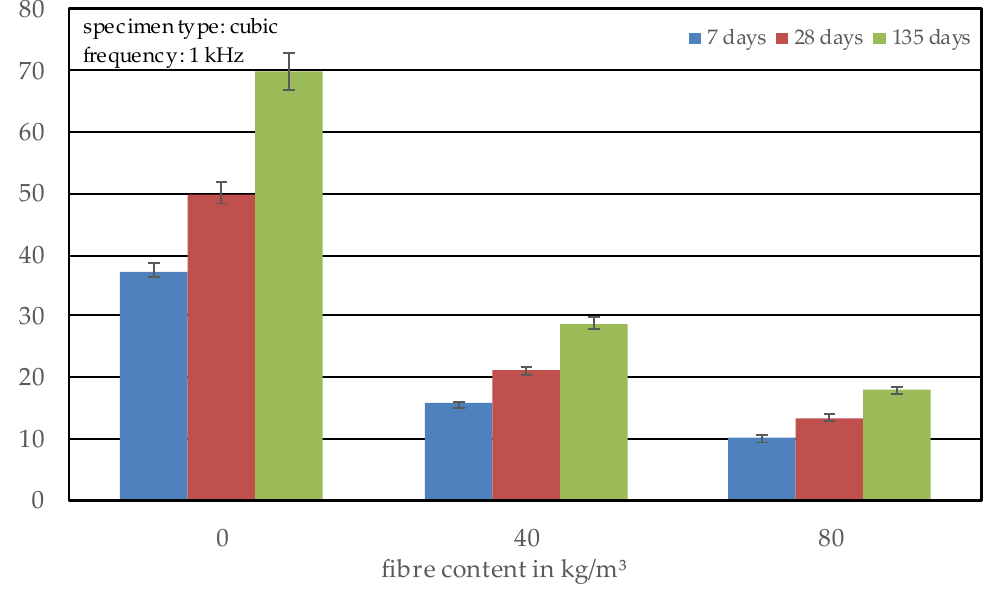
Figure 5. Electrical resistivity of the concrete cubes in different ages.